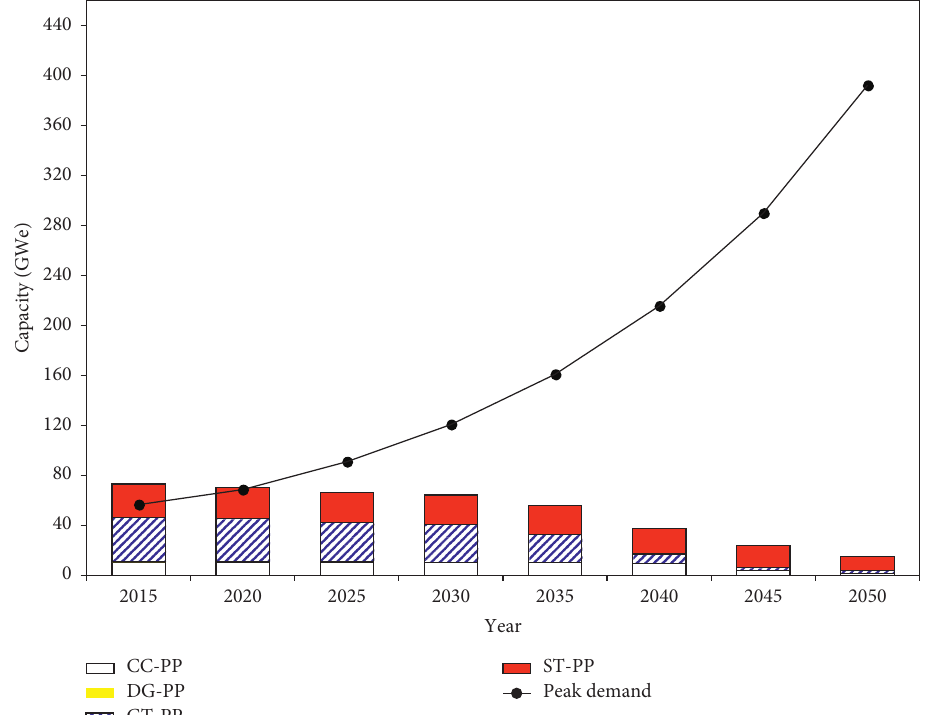
Figure 3: Simulation results from MESSAGE tool for Scenario I.